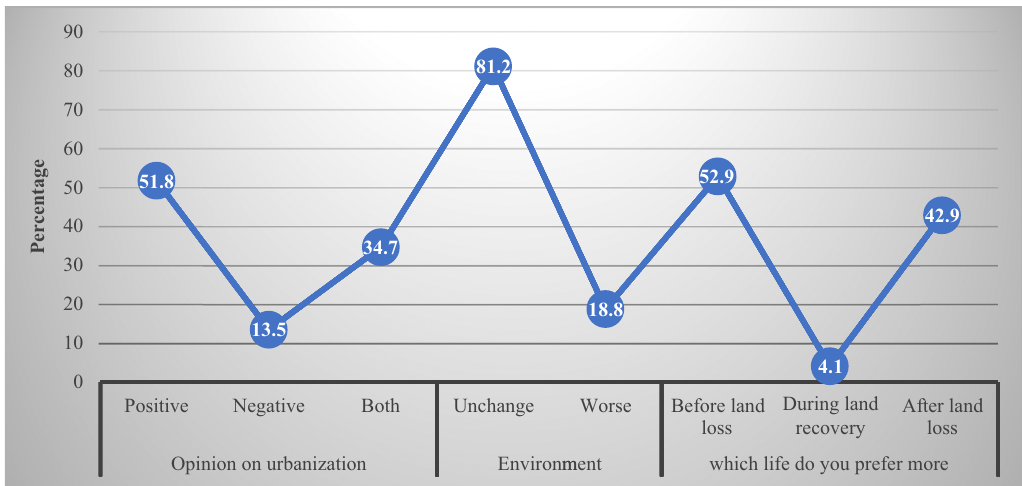
Figure 5: Perspectives, environment, and life choices. Source: Households ’ survey ( 2019 )